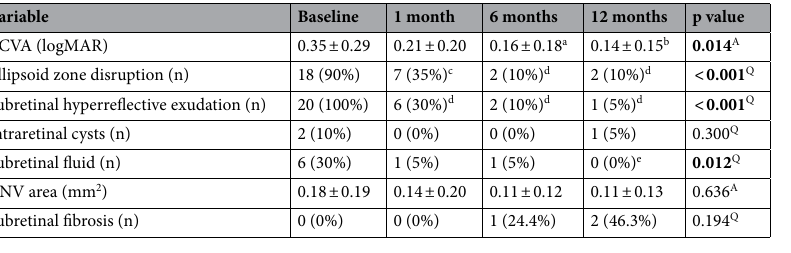
Table 4. Results of repeated variables over the follow-up study period in eyes with immature mCNV (n = 20). Significant values are in bold. A ANOVA test; Q Cochran’s Q test; a 0.035 (Tukey HSD vs baseline); b 0.017 (Tukey HSD vs baseline); c 0.001(McNemar vs baseline); d 0.001 (McNemar vs baseline); e 0.016 (McNemar vs baseline). BCVA Best-Corrected Visual Acuity, CNV Choroidal neovascularization, logMAR logarithm of the minimal angle of resolution; mm